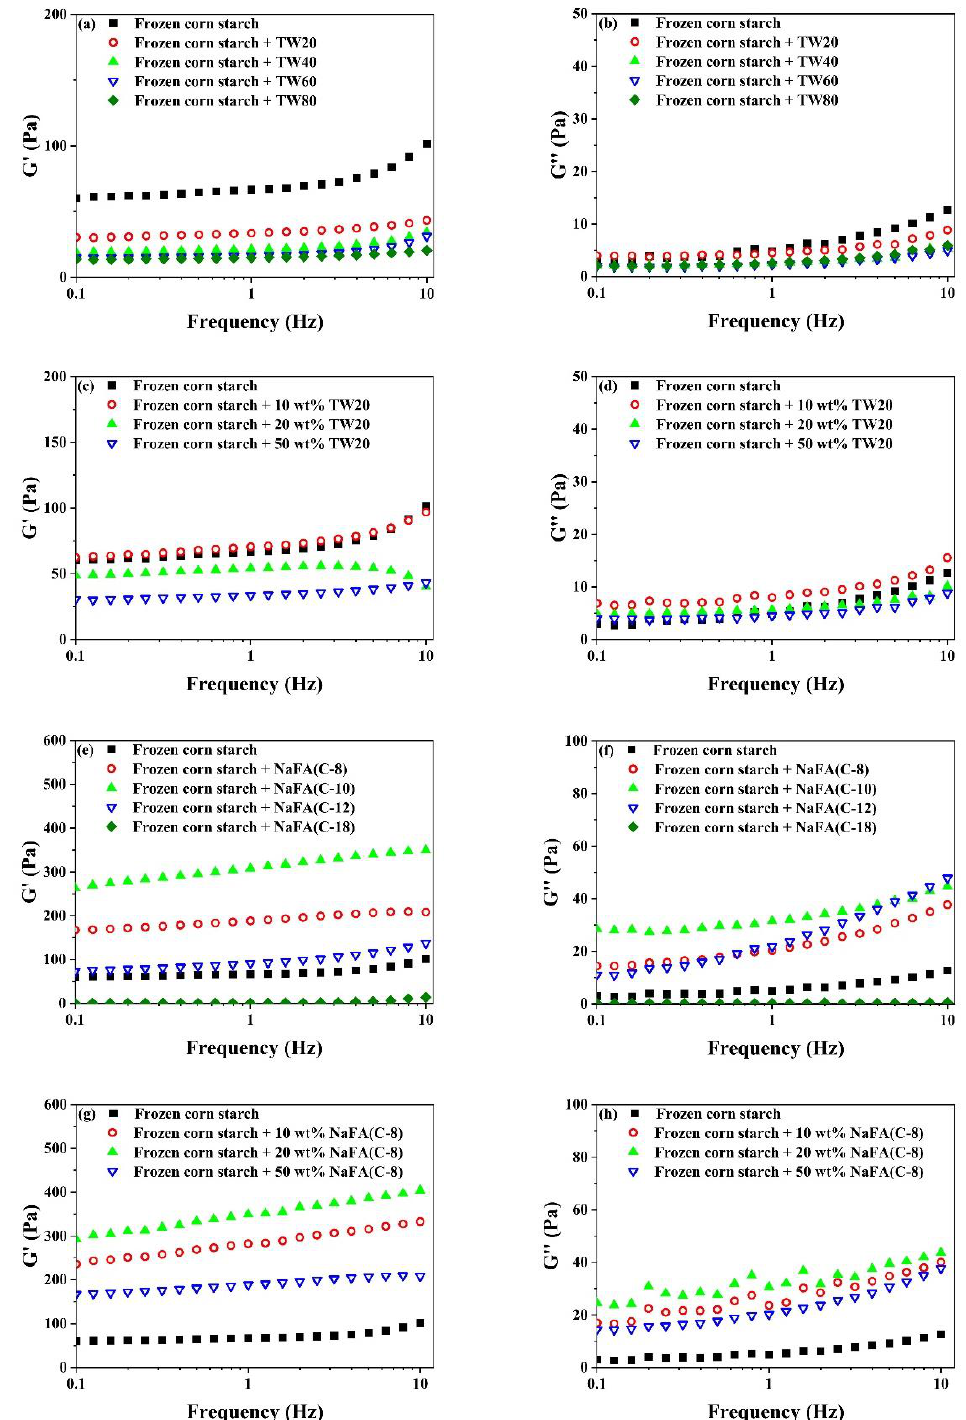
Figure 3. Rheological properties of regular ( a 0 – h 0 ) or frozen ( a – h ) corn starch in the presence of Tween (TW) and sodium fatty acid (NaFA). ( a 0 , a ) Elastic modulus (G ′ ) of corn starch in the presence of different types of TW (50 wt%). ( b 0 , b ) Viscous modulus (G ″ ) of corn starch in the presence of different types of TW(50 wt%). ( c 0 , c ) G ′ of corn starch in the presence of different concentrations of TW20. ( d 0 , d ) G ″ of corn starch in the presence of different concentrations of TW20. ( e 0 , e ) G′ of corn starch in the presence of different types of NaFA (50 wt%). ( f 0 , f ) G″ of corn starch in the presence of different types of NaFA (50 wt%). ( g 0 , g ) G′ of corn starch in the presence of different concentrations of NaFA (C-8). ( h 0 , h ) G″ of corn starch in the presence of different concentrations of NaFA (C-8).